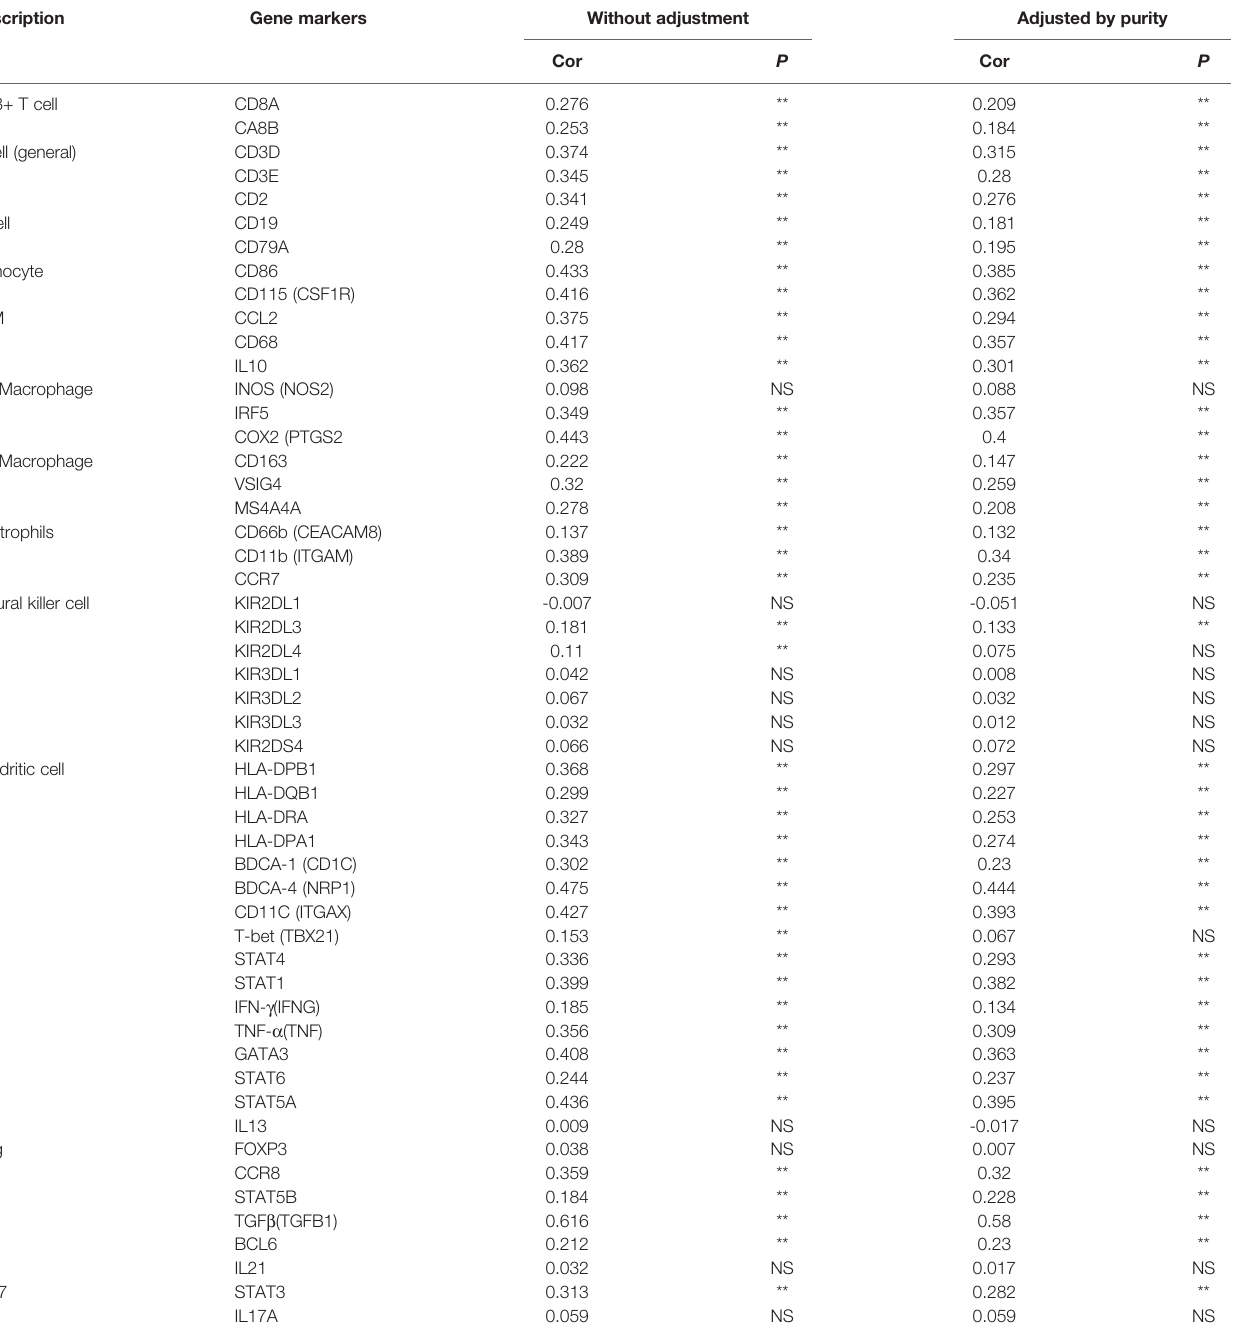
TABLE 2 | Correlation analysis between FAM57A expression and gene markers of immune cells in TIMER.